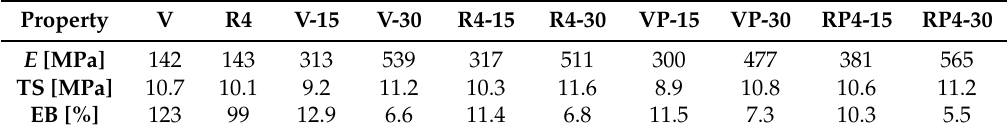
Table 5. Elastic modulus ( E ), tensile strength at break (TS), elongation at break (EB) for all of the